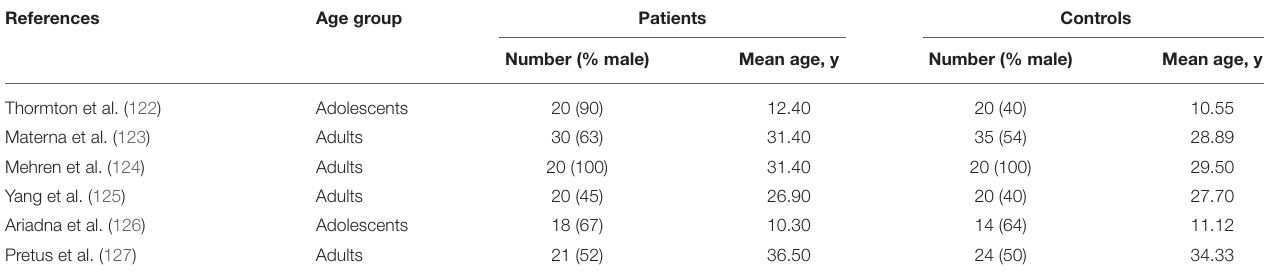
TABLE 2 | Demographic information for studies included in meta-analysis.